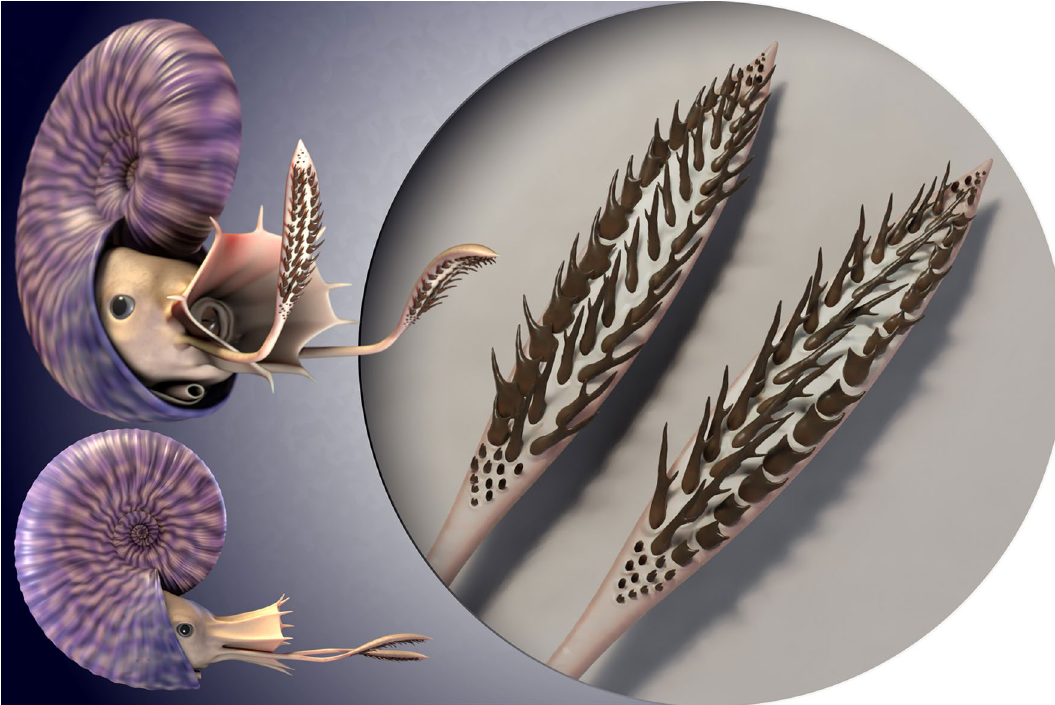
Figure 6. Hypothetical reconstruction of a R. halli tentacular club. The arrangement of the different morphotypes of hooks along the tentacular clubs was inferred based on the recurrent 3D patterns and morphotype associations identified in multiple specimens throughout this study, and comparisons with extant coleoid armatures. The size of the clubs is estimated, and falls within the range observed in modern coleoids. 3D reconstruction by A. Lethiers